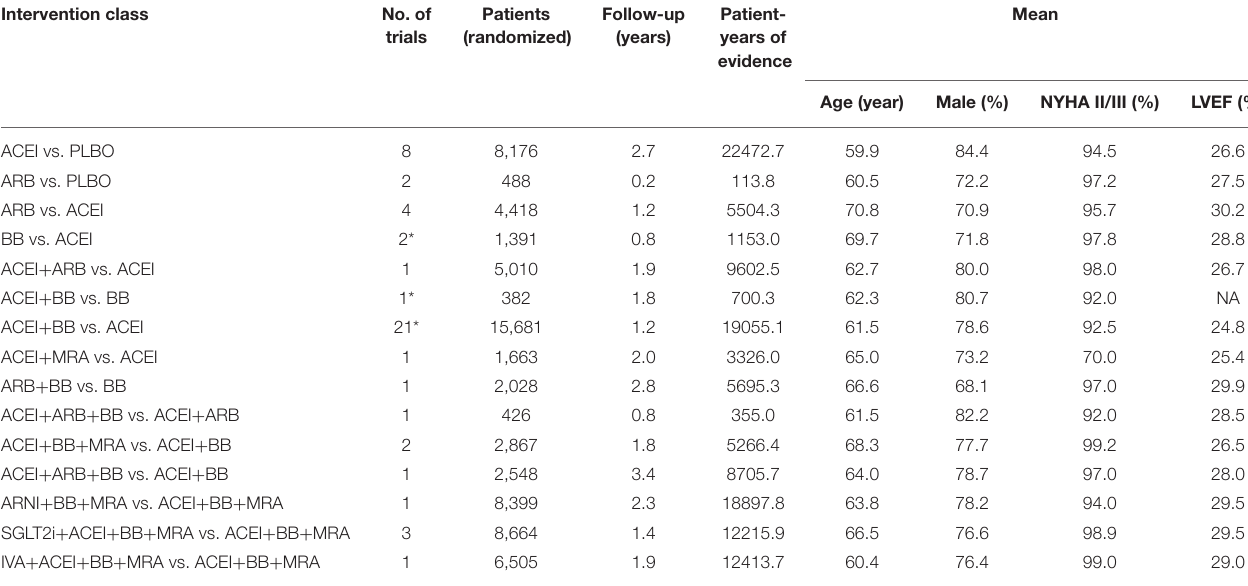
TABLE 1 | Study population characteristics. Intervention class